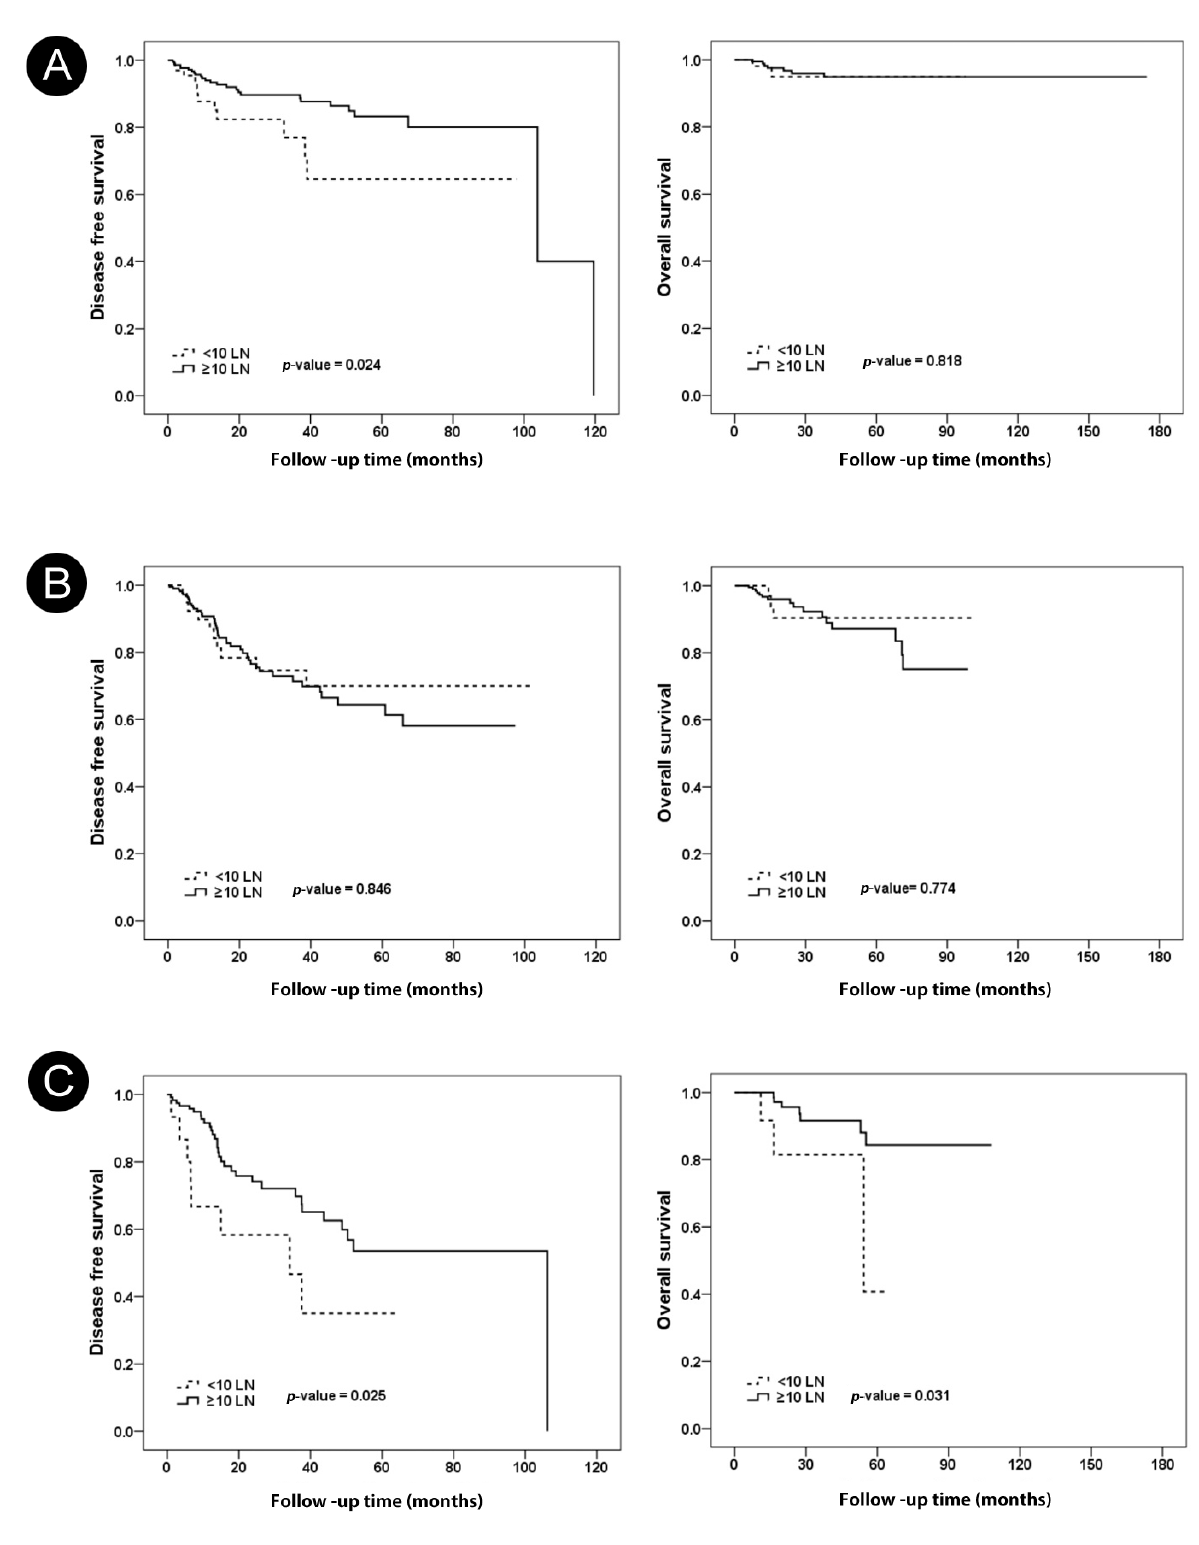
Figure 4. Impact of the number of lymph nodes on disease-free survival and overall survival of ypN0